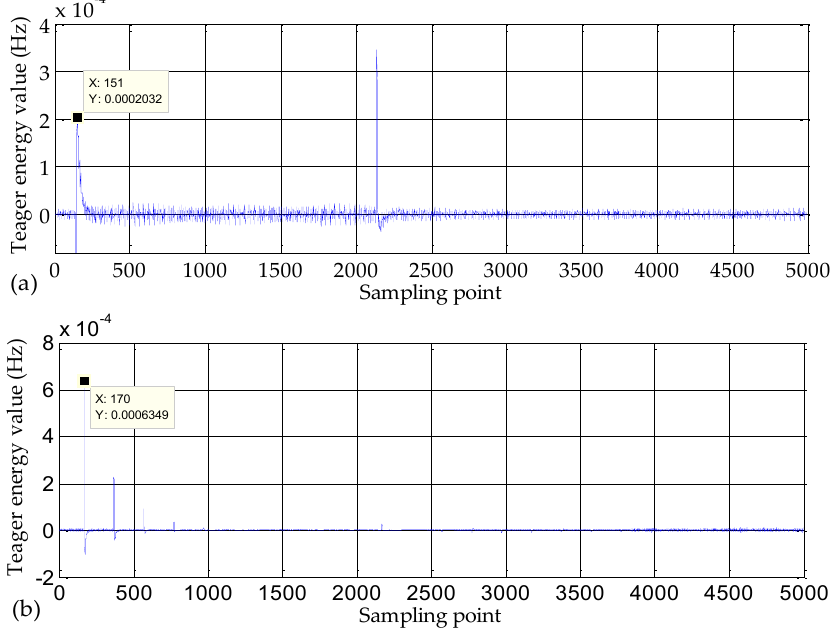
Figure 13. Intrinsic mode function 1 (IMF1) instantaneous energy spectrum: ( a ) At the terminal M and ( b ) At the terminal N.